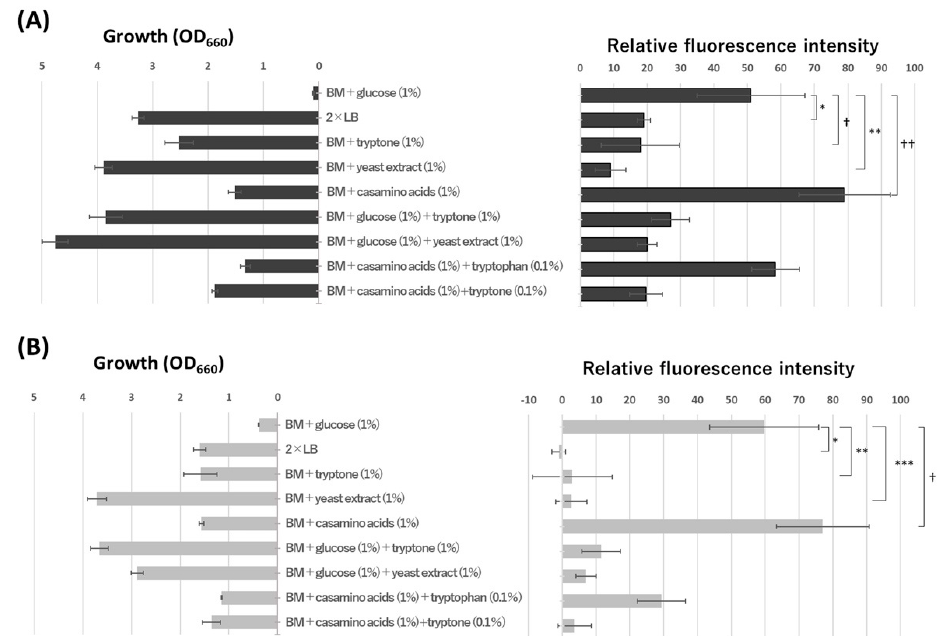
Figure 2. Oligotrophic gene expression under oligotrophic and eutrophic conditions. Washed cells of each reporter strain were inoculated into various media indicated in the figure at OD 660 = 0.01. After cultivation for 24 h at 30 °C, the fluorescence intensity of the cells was measured as described in the text. The value of each strain having pAldA-EGFP ( A ) or pMnoA-EGFP ( B ) as a reporter plasmid was obtained by subtracting that of the control strain having pNit-RK2 grown under the same conditions. The values are the means of triplicate experiments, and the error bars show the standard deviations. Statistical differences were ascertained by Student’s t -test, *, **, and *** represent p < 0.05; † and †† represent p > 0.09.